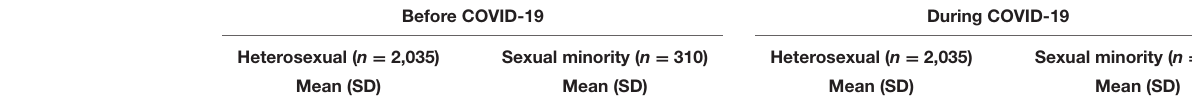
TABLE 2 | Psychological impact, substance use and addictive behaviors according to sexual